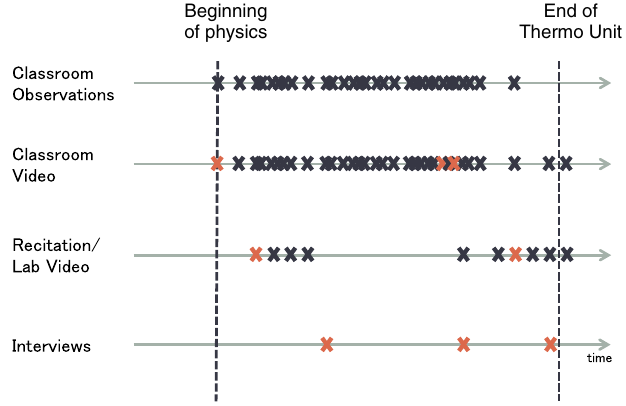
FIG. 2. A schematic of the various data streams collected. Time is represented along the horizontal axis and increases toward the right. The X ’ s on the timeline indicate days we collected data in that particular stream. Orange X ’ s represent data clips that are specifically analyzed in this